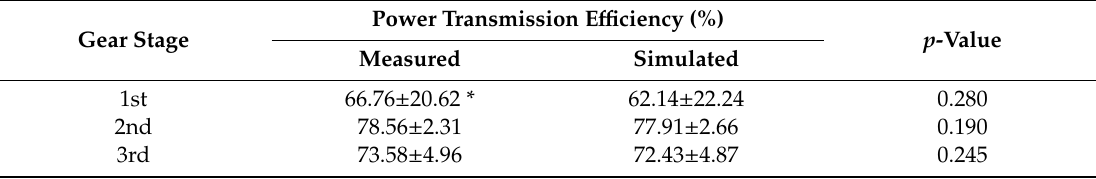
Table 5. Comparison of power transmission e ffi ciency between the measured and simulated results based on the gear